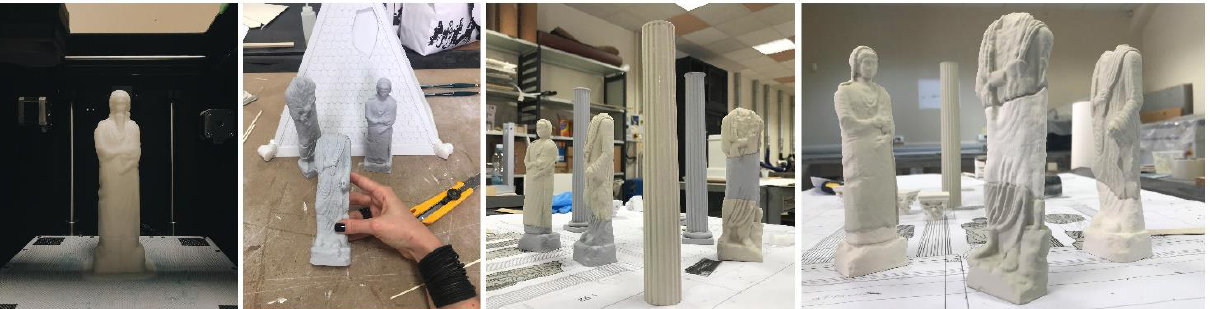
Figure 3: sequence of statues (3D printing, post-production, final finish)